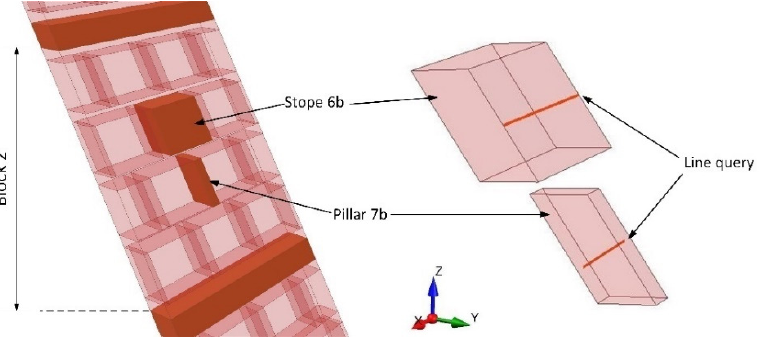
Figure 4. Location of the line queries at the hanging wall of the stope and the middle of the rib pillar.